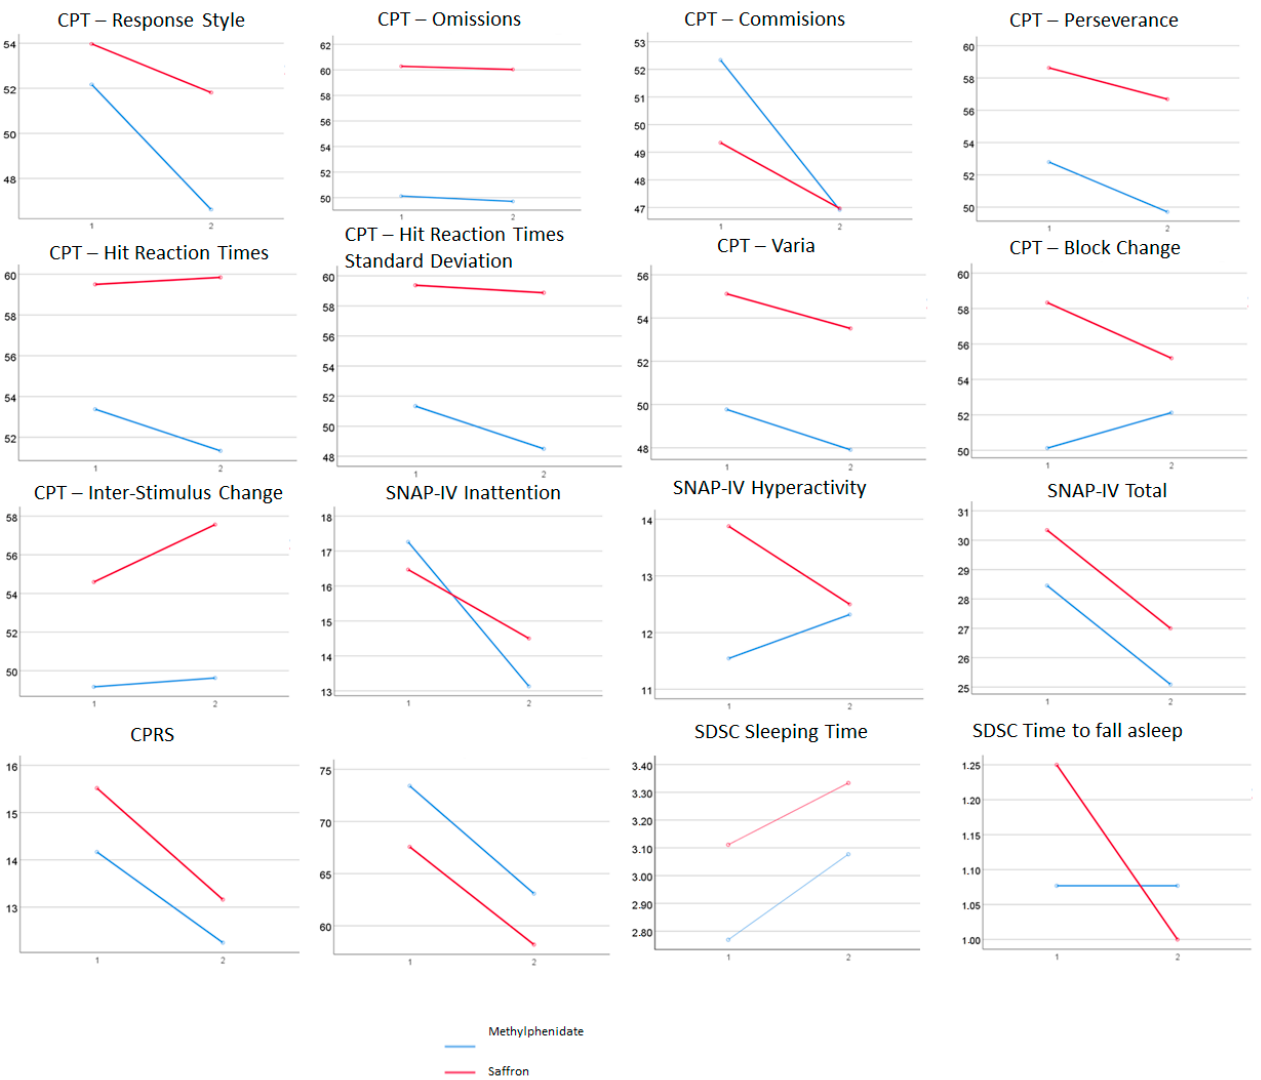
Figure 1. Interaction graphs for the ANOVAs. SDSC scales are not expressed in sleep hours or minutes until falling asleep, but in scores from Likert-type scales. Mean scores of SDSC Sleeping Time are approximately equivalent to sleep for 7–8 h (pre) and 8–9 h (post). Mean scores of SDSC Time to Fall Asleep are approximately equivalent to around 30 min (pre in saffron group), 15 (post in saffron group), and 15–30 min (pre and post in methylphenidate group).